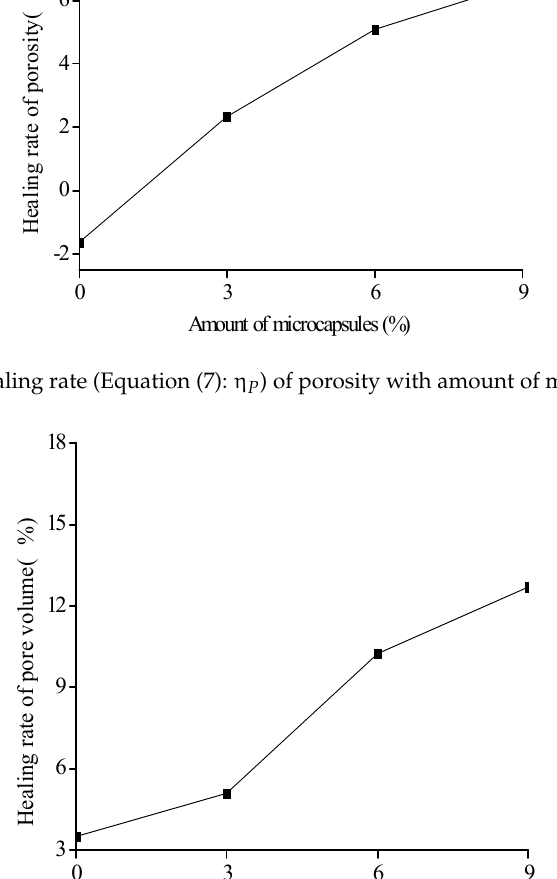
Figure 19. Healing rate (Equation (8): η V ) of pore volume with amount of microcapsules.